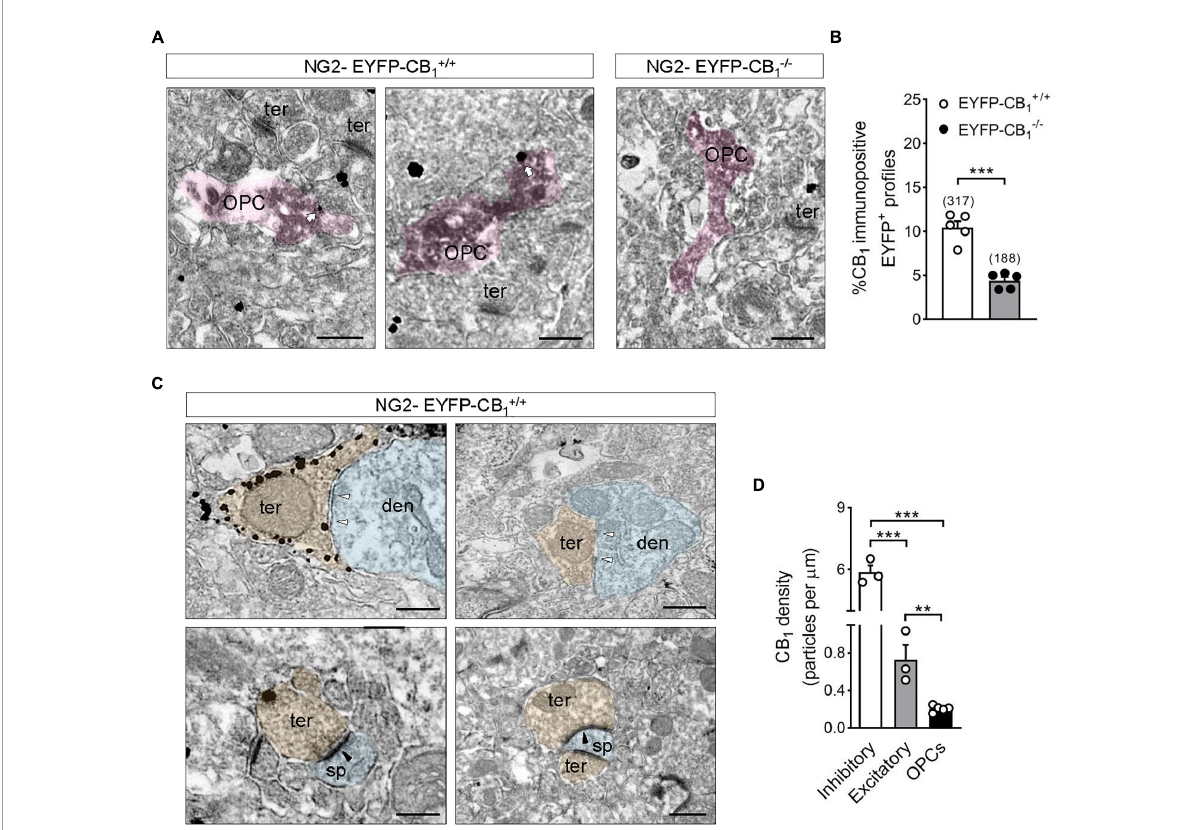
FIGURE2 Electron microscopy localization of CB 1 receptors in OPCs of the adult mouse hippocampus. (A) Representative electron micrographs showing pre-embedding silver intensified immunogold labeling of CB 1 receptors and immunoperoxidase labeling of EYFP in coronal brain sections from adult NG2-EYFP mice. CB 1 receptor gold particles were localized on plasma membranes of OPC processes (white arrows). Scale bars: 500 nm. (B) Quantification of CB 1 receptor immunopositive OPC profiles in NG2-EYFP ± mutant mice. The proportion of DAB positive profiles expressing CB 1 receptor metal particles was significantly lower in NG2-EYFP-CB 1 - / - mice. The numbers in parentheses on the top of each column indicate the number of OPC processes analyzed. (C) Distribution of CB 1 receptors in synaptic terminals of NG2-EYFP ± mice. Scale bars: 500 nm. White arrowheads, inhibitory synapses; black arrowheads, excitatory synapses; den, dendrite (blue); opc, oligodendrocyte progenitor (pink); sp, dendritic spine (blue); ter, terminal (orange). (D) CB 1 receptor density (particles/ µ m plasma membrane) was quantified in receptor